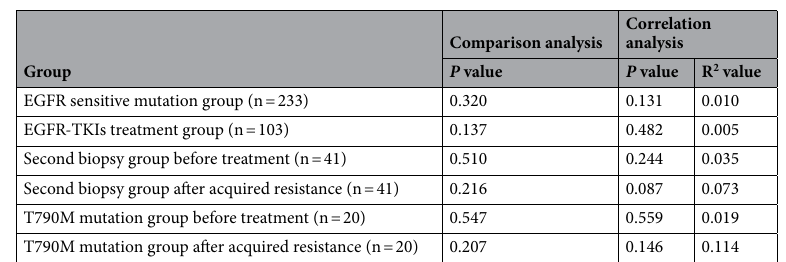
Table 5. Relationship analysis between HIF-1α level and clinical stage through HIF-1α level comparison analysis among stages and correlation analysis between stage and HIF-1α level.